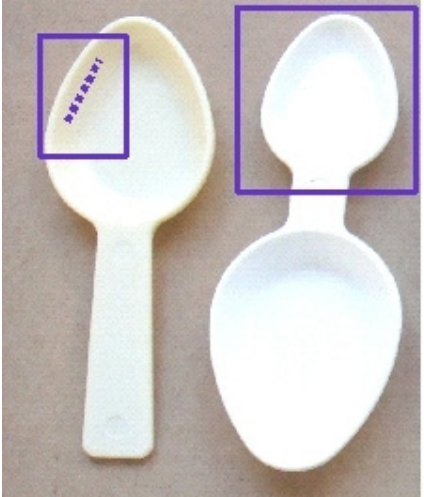
Figure 4. Example of full or half volume spoons (in purple square).